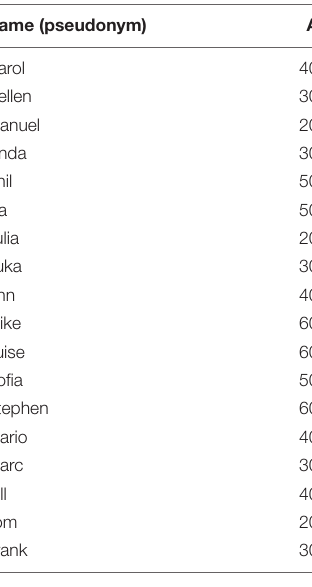
TABLE 1 | Tourists’ characteristics (10 men and eight women).